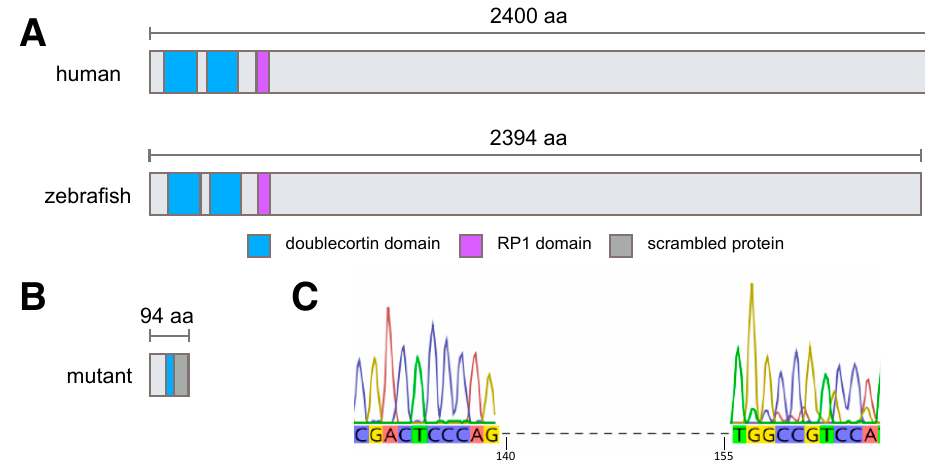
Figure 1. Human and zebrafish RP1L1 proteins have conserved domains, which are predicted to be eliminated in rp1l1 mutant zebrafish . ( A ) Cartoon of human and wild-type zebrafish proteins. Human and zebrafish RP1L1 have conserved domains and are similar sizes, with human RP1L1 protein being 2400 amino acids (aa) and zebrafish Rp1l1 protein being 2394 amino acids in length. ( B ) The mutation in zebrafish rp1l1 is predicted to result in a severely truncated, nonfunctional Rp1l1 protein. The mutation occurs in the first doublecortin domain of Rp1l1 after amino acid 52, resulting in significant loss of more than half of the doublecortin domain, which is followed by an abnormal protein extension and termination at 94 amino acids in length. ( C ) The CRISPR/Cas9-generated 16 bp deletion in zebrafish rp1l1 occurs after nucleotide 139.